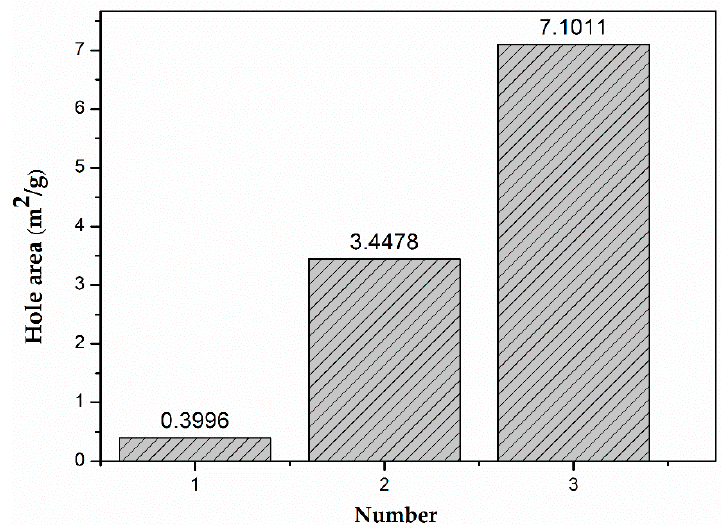
Figure 8. The hole area of the hydrogels ( 1 ) without GO, ( 2 ) with 20 mg of GO, and ( 3 ) with 30 mg of